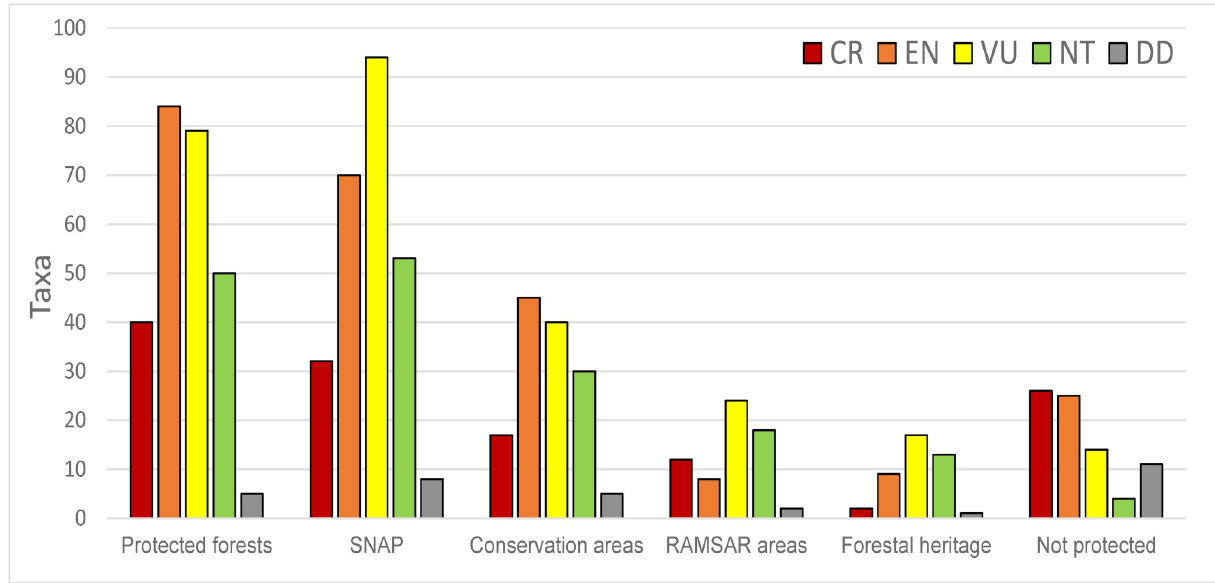
Fig 10. The IUCN Red List of amphibians from Ecuador representation in the National System of Protected Areas. Categories: CR = Critically Endangered, EN = Endangered, VU = Vulnerable, NT = Near Threatened, LC = Least Concern, DD = Data Deficient. SNAP–Governmental National System of Protected Areas, from the Spanish